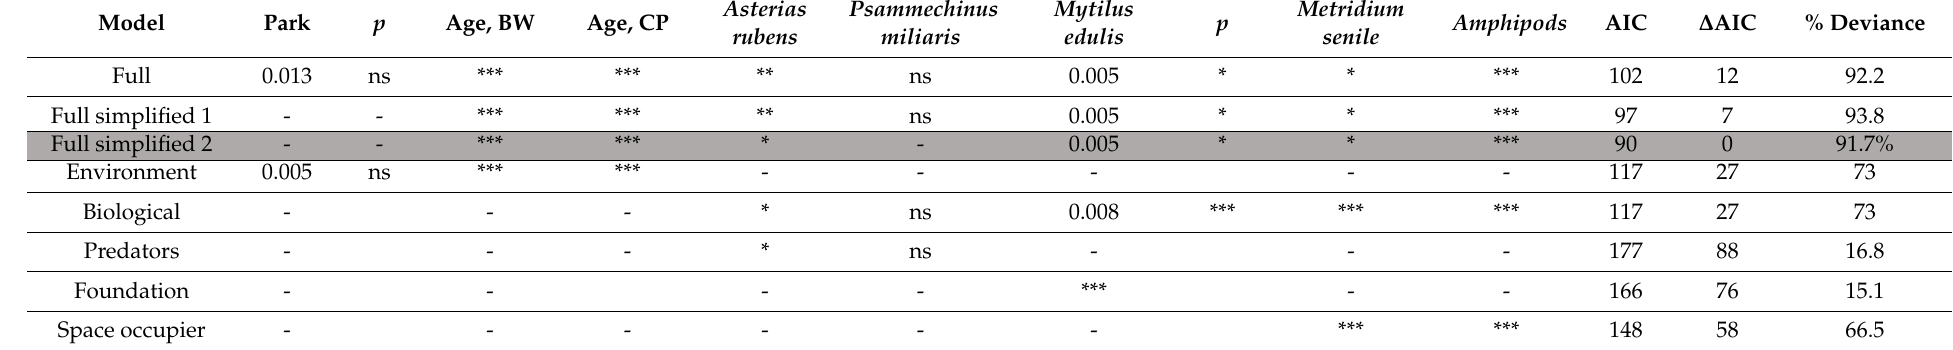
Table 4. Overview of the full model and alternative models considered (excluded variables indicated with -) for diversity. The model with the best fit is highlighted. (All other models had a ∆ AIC value >6 and explained only 2% of extra deviance). p -value for all of the variables ( p < 0.001: ***, p < 0.01: **, p < 0.05: *, p < 0.1: ns) and estimate for linear